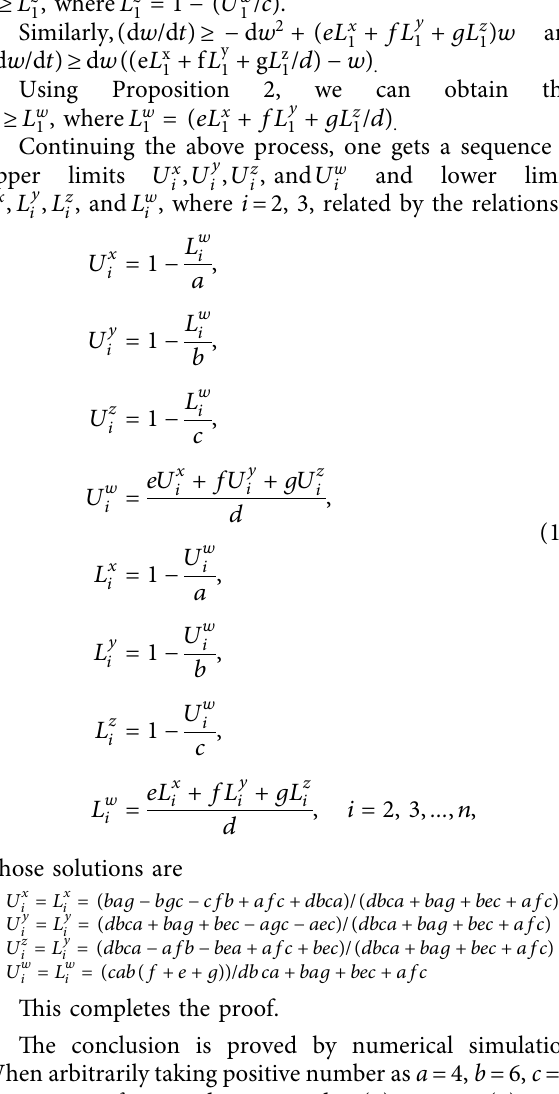
x y Figure 9: Positive parameters a � 2, b � 4, c � 5, d � 5, e � 2, f � 2, and g � 2 corresponding to internal solution in equation (16) as (0.5652, 0.7826, 0.8261,